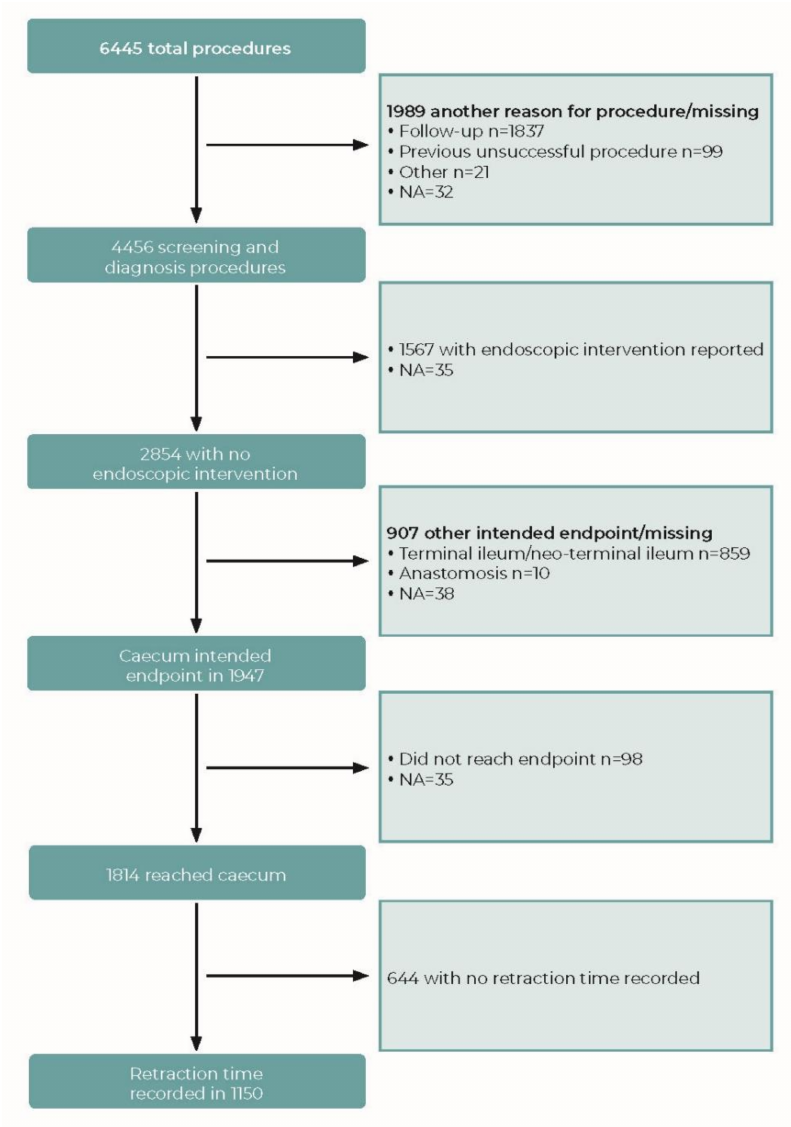
Figure 1. Flowchart indicating data inclusion/exclusion for analysis of withdrawal time (WT). NA: not